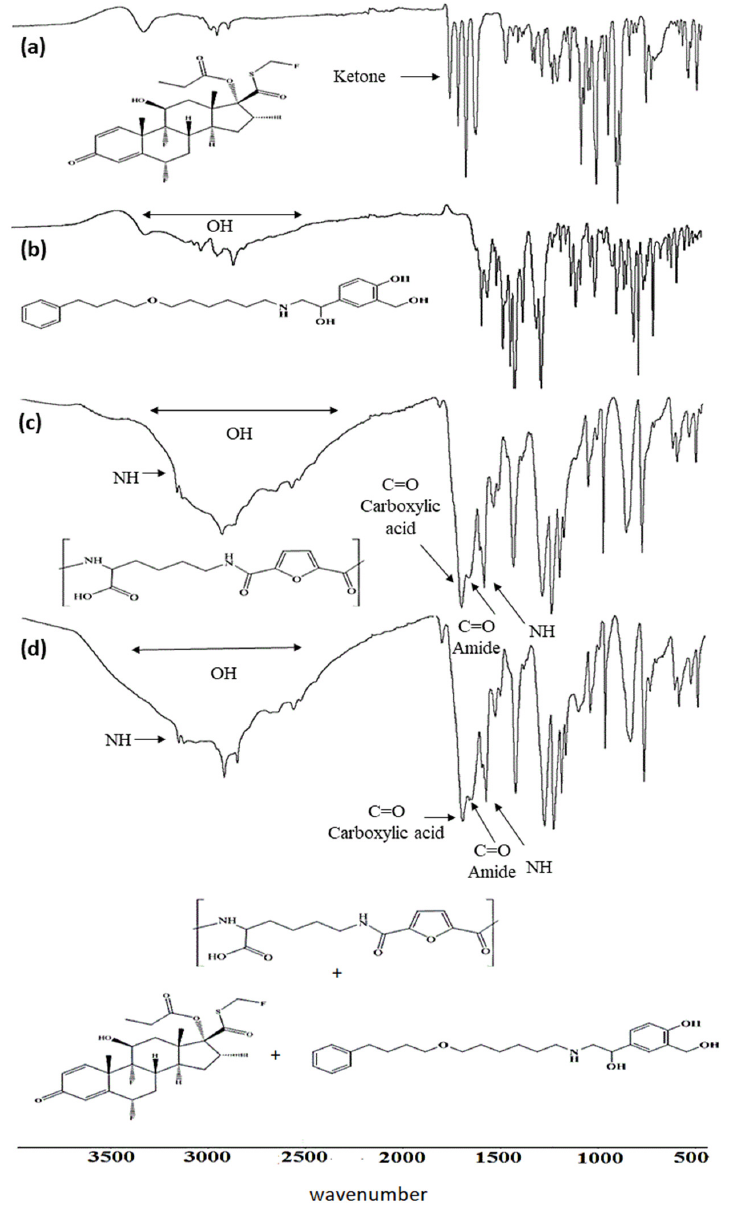
Figure 2. FTIR spectra of ( a ) fluticasone propionate (FP), ( b ) salmeterol xinafoate (SAL), ( c ) polyamide based on lysine, ( d ) and polyamide based on lysine formula.